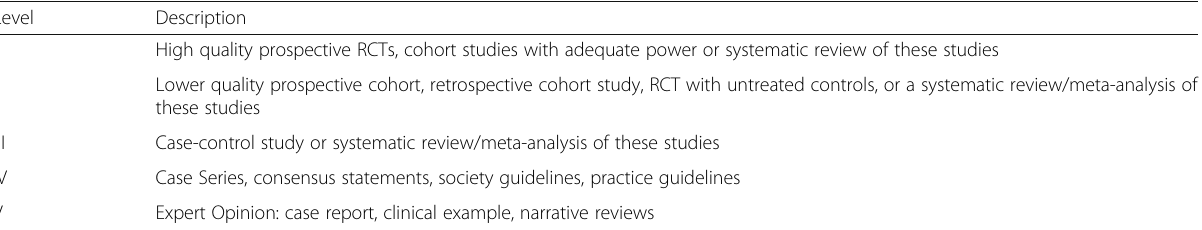
Table 5 Levels of Evidence Adapted from the American Society of Plastic Surgeons and Johns Hopkins nursing evidence-based practice: Models and Guidelines (Burns et al. 2011; Dang and Dearholt